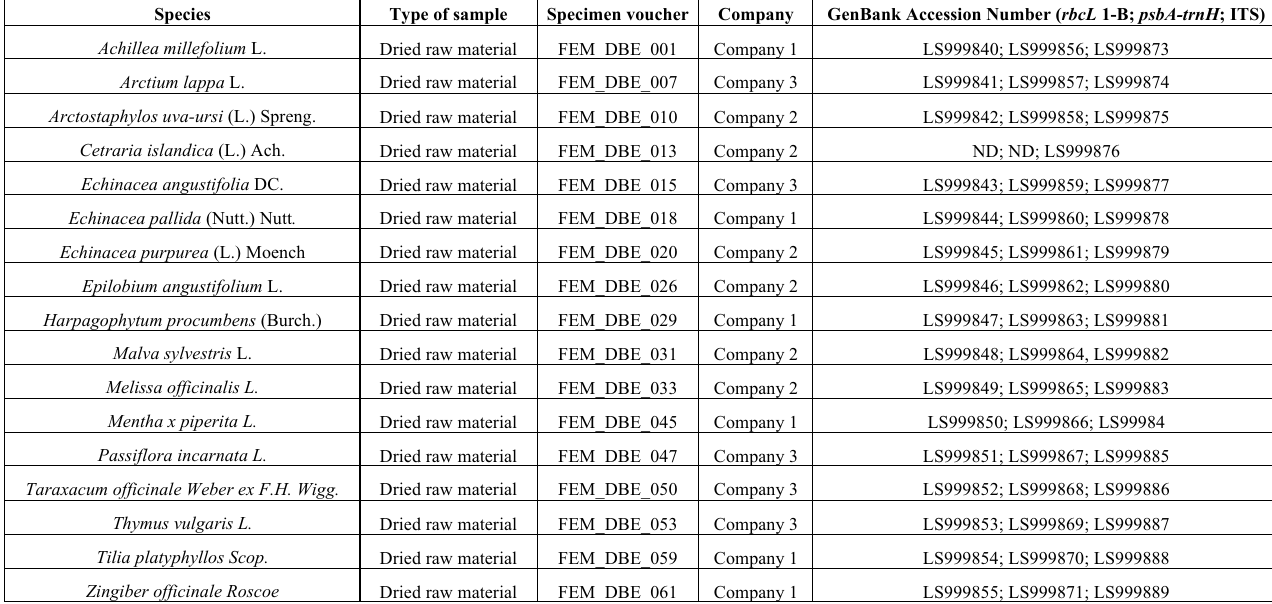
Tab. A.2: List of all the analysed plant species. The table include the voucher specimens and GenBank accession numbers of the raw material samples used to authenticate the phytoextracts and their intermediates of industrial production treated in this study.